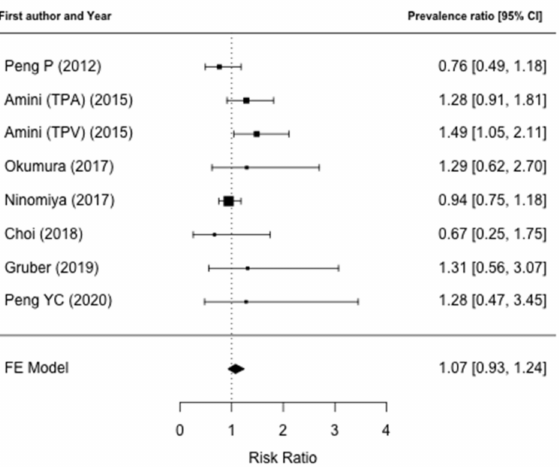
Figure 2. Forest plot for the prevalence ratio of major complications. Meta-analysis did not identify a higher prevalence ratio of major complications after pancreatic surgery in the low muscle mass group.